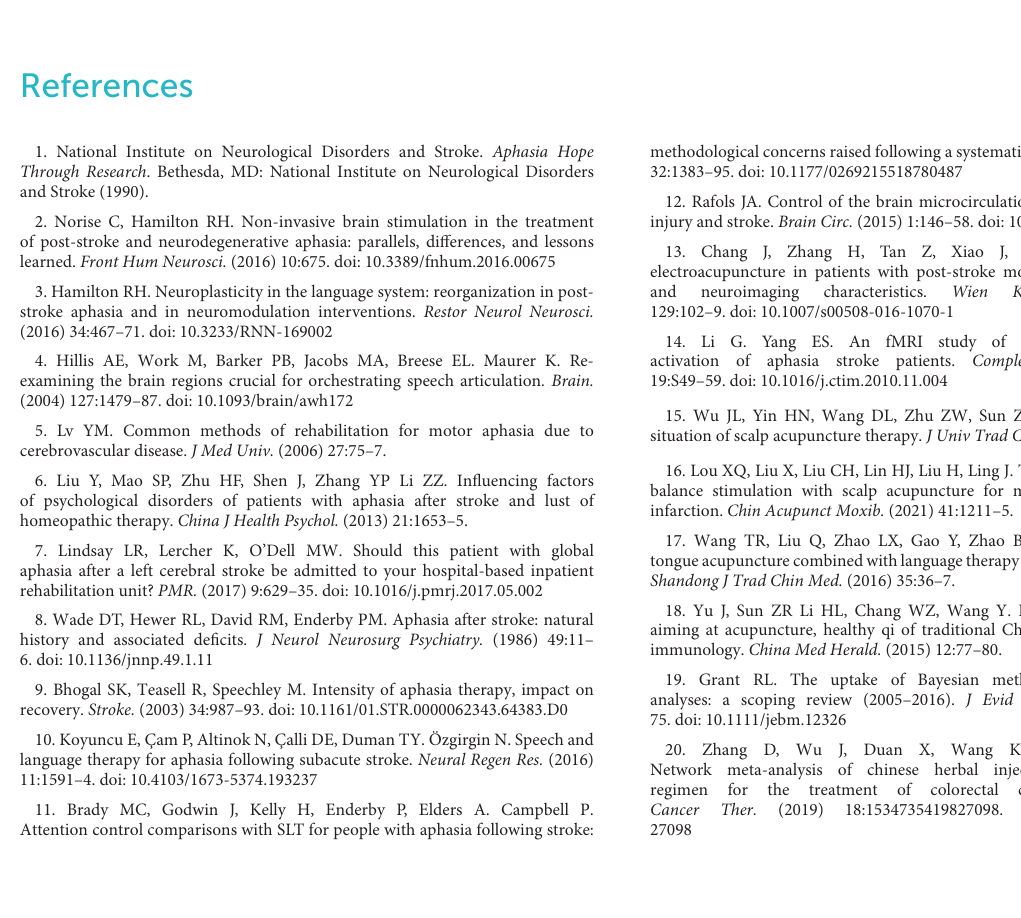
SUPPLEMENTARYFIGURE2 Summary chart of quality assessment. SUPPLEMENTARYFIGURE3 Probability ranking results of CER of different interventions. ST, Speech training; BA, body acupuncture; SA, scalp acupuncture; TA, tongue acupuncture; SBA, scalp-body acupuncture; STA, scalp-tongue acupuncture. SUPPLEMENTARYFIGURE4 PSRF diagnostic diagram for CER. SUPPLEMENTARYFIGURE5 Loop inconsistency tests. ST, Speech training; BA, body acupuncture; SA, scalp acupuncture; TA, tongue acupuncture; SBA, scalp-body acupuncture; STA, scalp-tongue